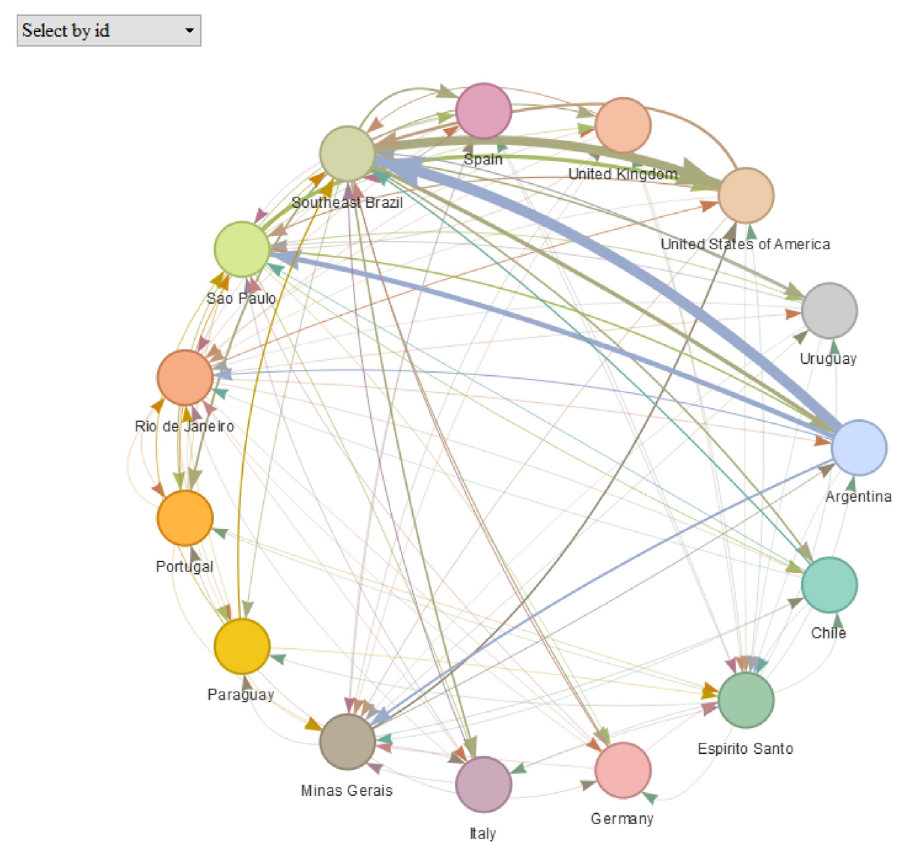
Figure 3. Population flows between Brazil states and other locations plotted using type = "network" .